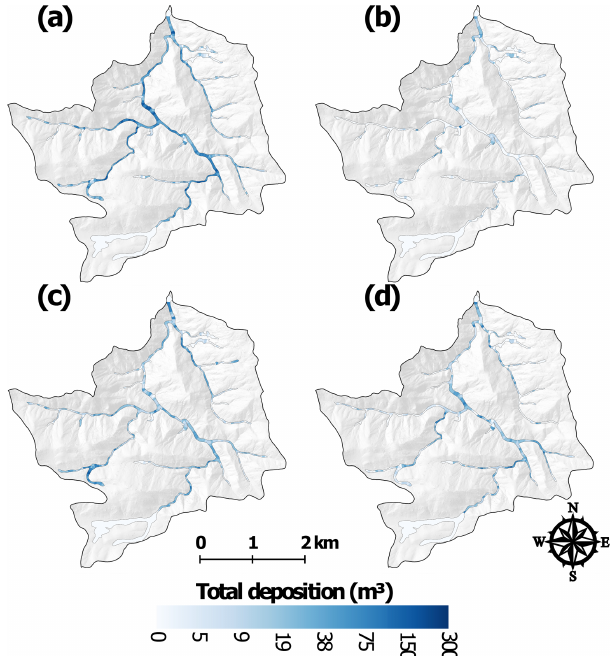
Figure A1. Total deposition for each valley bottom segment in Hill Gulch for (a) 201210–201307, (b) 201307–201310, (c) 201310–201409, and (d) 201409–201506. Calculated volumes are not reported for the transparent segments due to unrealistically wide valley widths, repeat excavations, or the ground surface not being reliably determined.